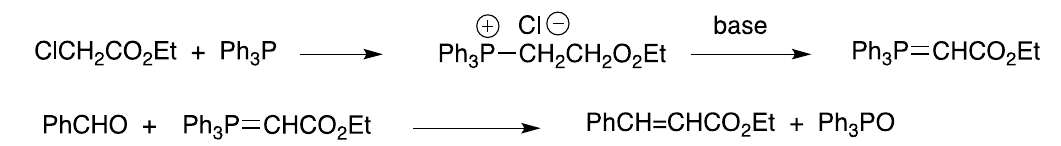
Scheme 3. Whole process of a typical Wittig reaction using a stabilized phosphonium ylide.